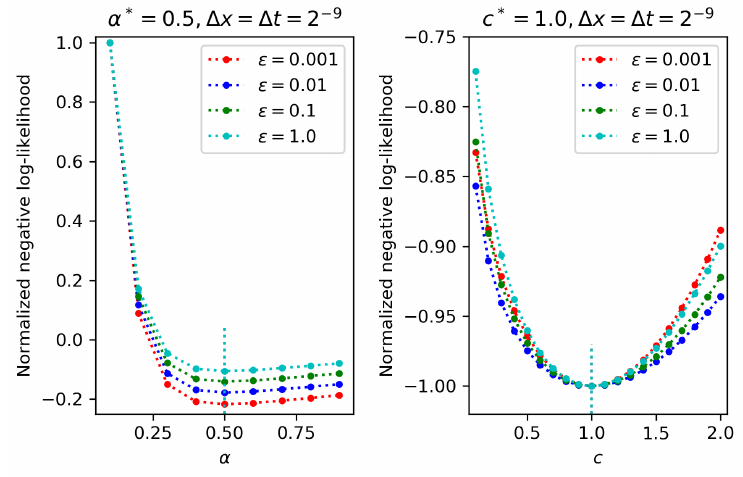
Figure 5. One-parameter estimation for a full observation: Negative log-likelihood curves for varying α and fixed c ∗ = 1.0 ( left ) and for varying c and fixed α ∗ = 0.5 ( right ). The effect of noise magnitude on the optimal parameters is demonstrated. Curves for different noise magnitudes are displayed in different colors. The spatio-temporal steps are fixed to those of a full observation, i.e., ∆ = ∆ = 2 − 9 . 0 t 0 x